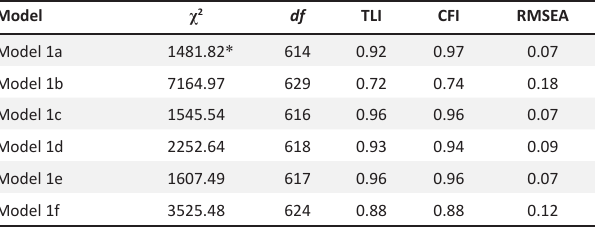
TABLE 1: Fit statistics of measurement